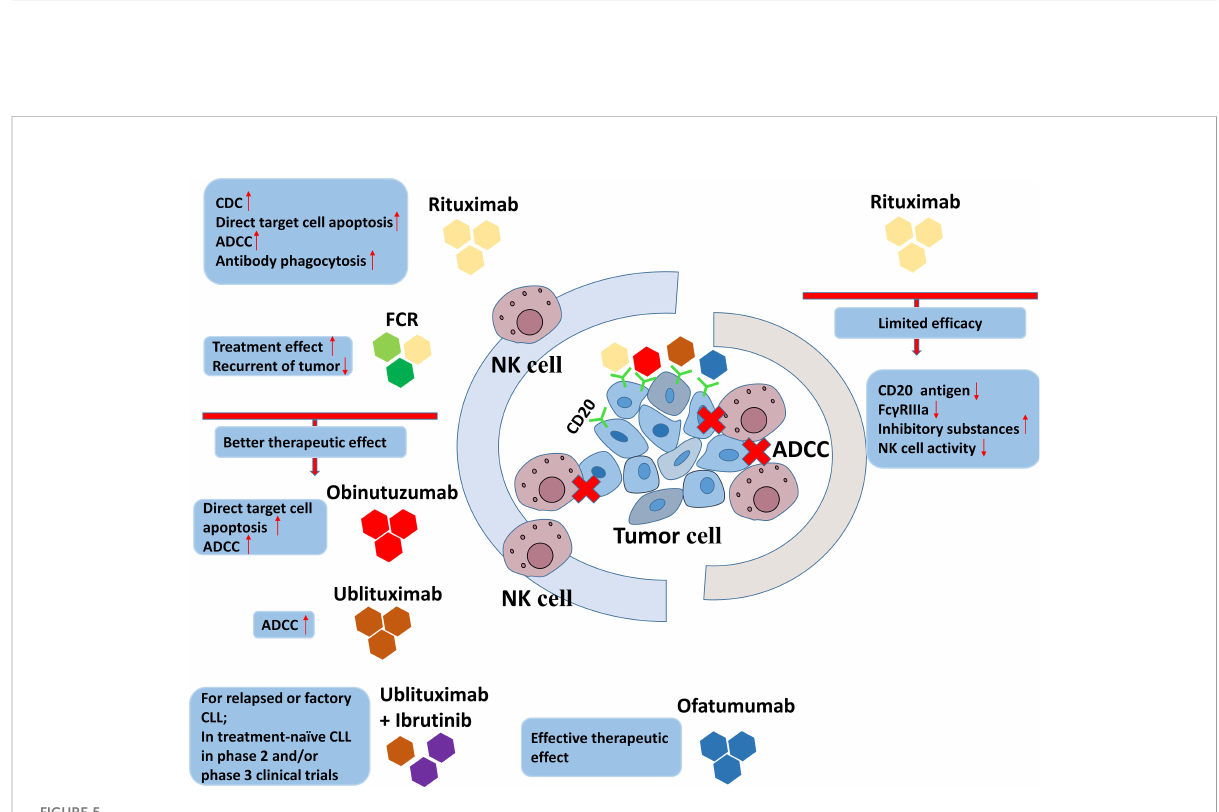
FIGURE 5 The antitumor mechanisms of anti-CD20 mAbs.